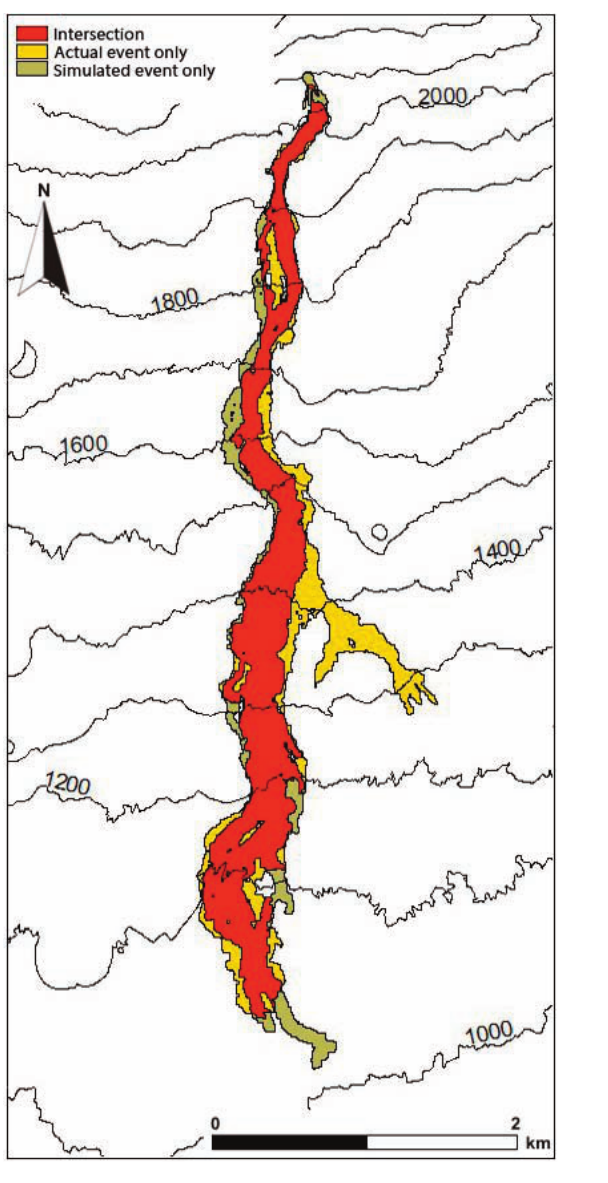
Figure 1. SCIARA simulations for the 2001 (a) and 2006 (b) lava-flow events at Mount Etna. In both cases the new model reproduced the events with a good level of agreement (area in